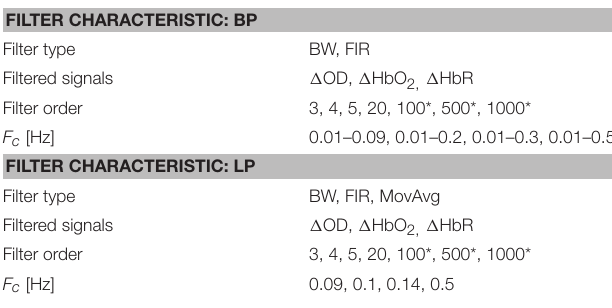
TABLE 1 | Type of filter and filer specifications resulting from the literature review process. FILTER CHARACTERISTIC: